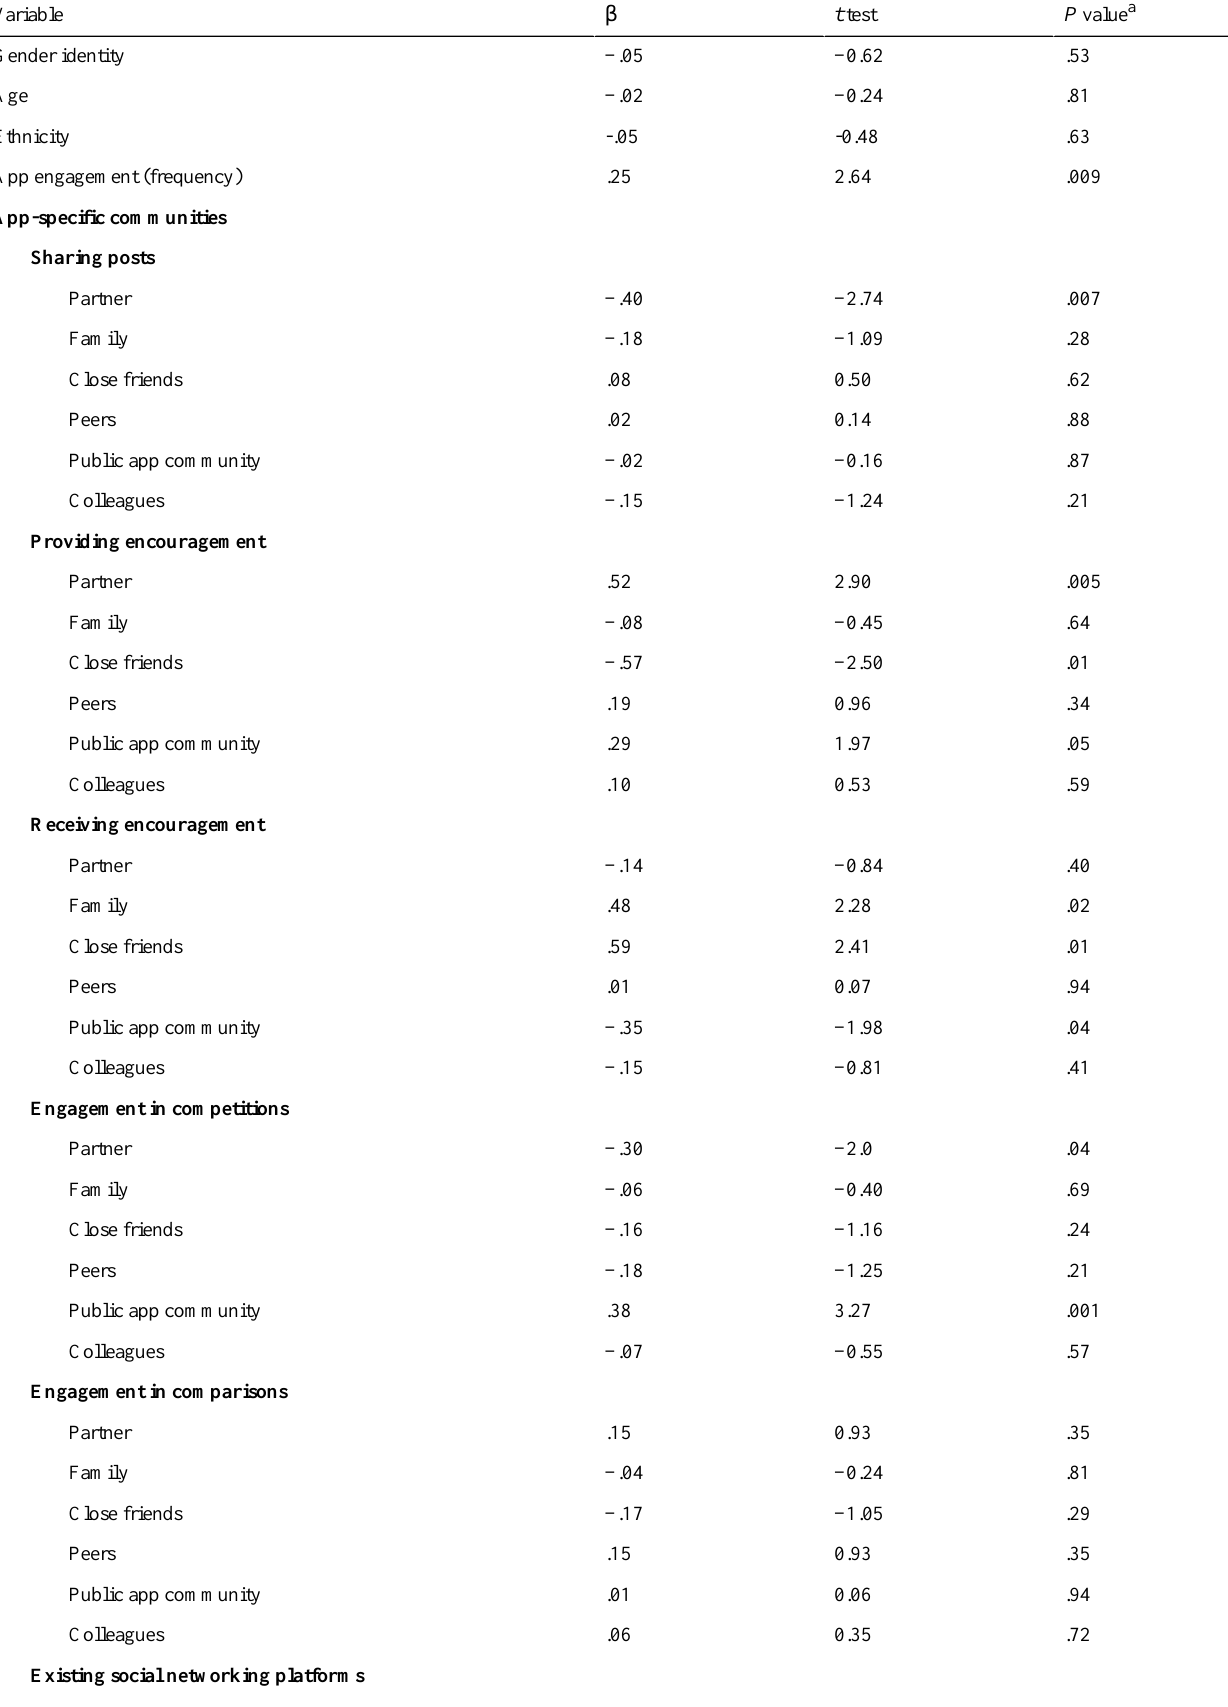
Table 3. Multiple regression analysis examining predictors of structured physical activity among app users